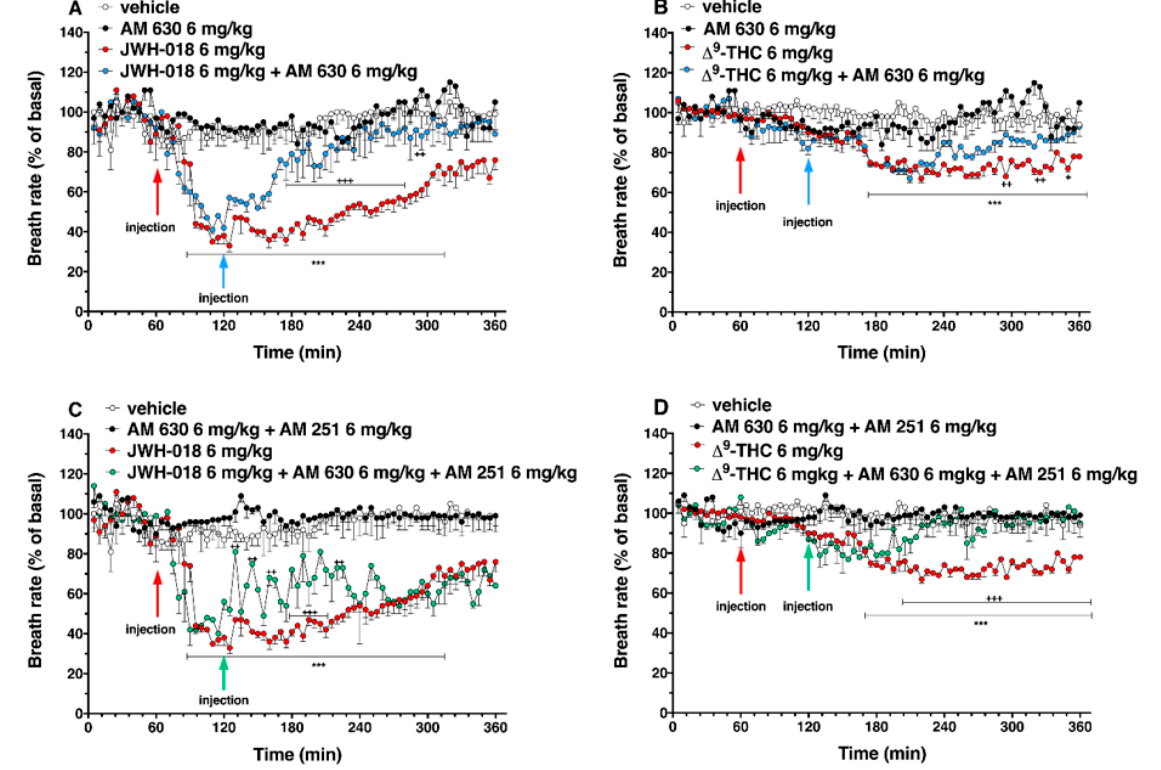
Figure 13. Interaction of JWH-018 (6 mg/kg i.p, panel ( A )) and ∆ 9 -THC (6 mg/kg i.p, panel ( B )) with the selective CB 2 receptor antagonist AM 630 (6 mg/kg, i.p.) on breath rate. Interaction of JWH-018 (6 mg/kg i.p, panel ( C )) and ∆ 9 -THC (6 mg/kg i.p, panel ( D )) with the administration of the mixture of selective CB 1 (AM 251; 6 mg/kg, i.p.) and CB 2 (AM 630; 6 mg/kg, i.p.) receptor antagonists on breath rate. Data are expressed as percentage of basal values in the form MEAN ± SEM of 8 different evaluations for each group. Statistical analysis was performed by two-way ANOVA, followed by Bonferroni’s test for multiple comparisons *** p < 0.001 versus vehicle, and + p < 0.05, ++ p < 0.01, +++ p < 0.001 versus AM 630 + agonists or AM 630 and AM 251 + agonists.